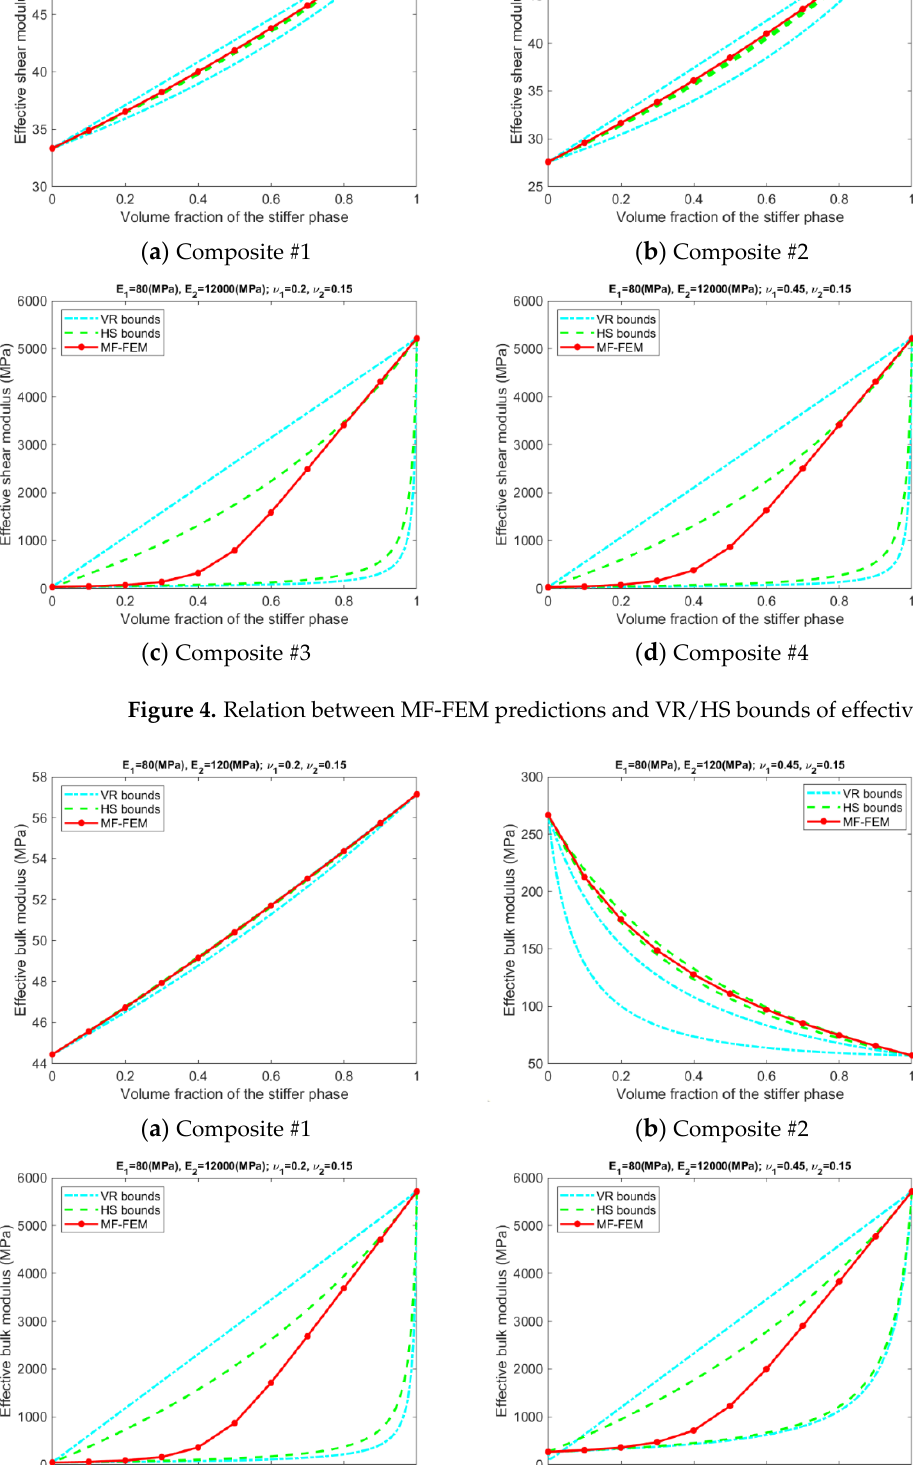
Figure 5. Relation between MF-FEM predictions and VR/HS bounds of effective bulk modulus.